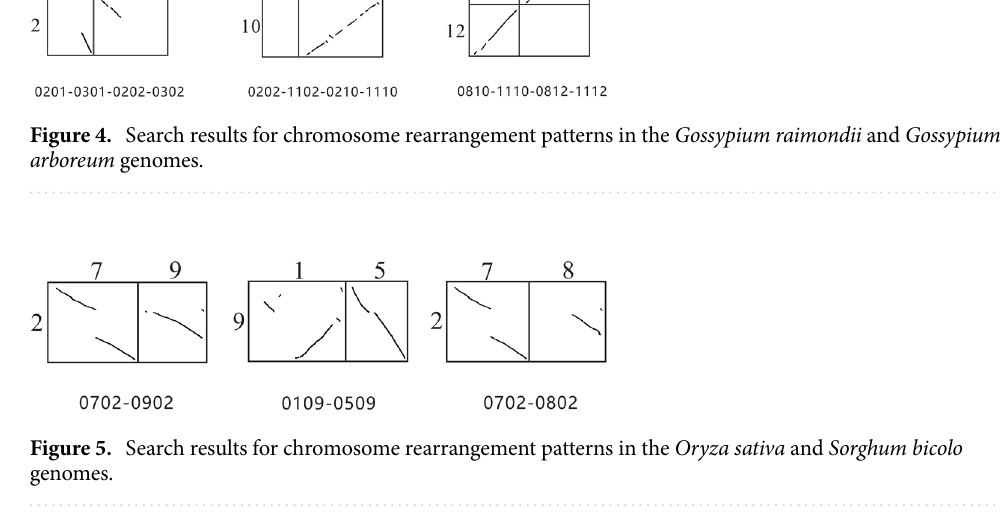
9. The combination of 0409-0809 is upside-down compared to the standard pattern. The number of collinear fragments for the 0703-1003 combination and the 0203-0503 combination is significantly different from the standard pattern. From the constructed Brassica rapa genome data, EntroCR found the combination of four patterns respec- tively, among which 0102-0302-0106-0306 is CIIJ pattern, 0508-0908-0510-0910 is CIEJ pattern, 0203-0703 is CEEJ pattern, 0409-0809 is NCF pattern. In addition, other combinations are quite different from the standard pattern, which verifies the validity of the model and shows that EntroCR has a certain search performance. Search for rearrangement patterns of Gossypium raimondii and Gossypium arboreum . The K dotplot between the genomes of Gossypium raimondii and Gossypium arboreum is selected as the research object.